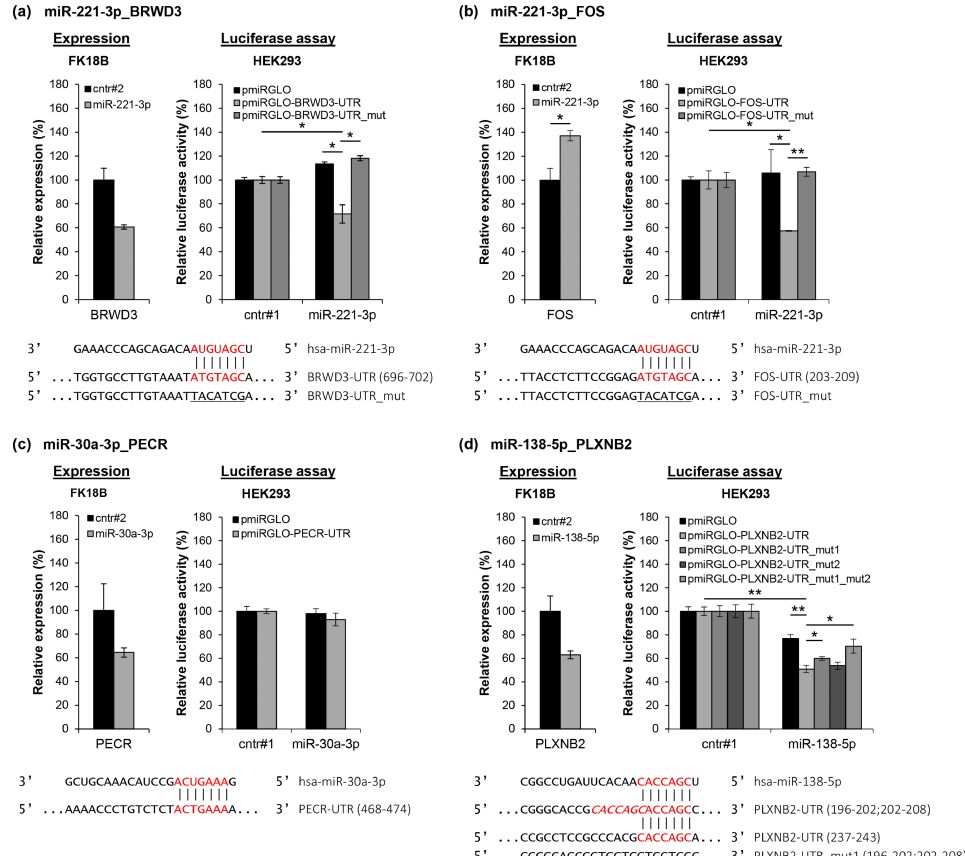
Figure 4. Confirmation of miRNA-mRNA interactions. Predicted miRNA-mRNA interactions ( a ) miR-221-3p_BRWD3, ( b ) miR-221-3p_FOS, ( c ) miR-30a-3p_PECR, and ( d ) miR-138-5p_PLXNB2 were investigated using mRNA expression analysis and dual-luciferase reporter assays. Left panel: E ff ects of ectopic expression of the miRNA on the expression level of its predicted mRNA target. Expression levels were determined by qRT-PCR in late passage FK18B cells (ca. passage 190) transfected either with a negative control (cntr#2) or with the respective miRNA mimic. Data was normalized to SNRPA. Mean and standard deviation of two technical replicates are shown. Right panel: Dual-luciferase reporter assay to confirm direct interaction between the miRNA and its predicted target mRNA. HEK293 cells were transiently transfected with a negative control (cntr#1) or the respective miRNA mimic in combination with either an empty pmiRGLO vector, a pmiRGLO construct containing the predicted binding site (pmiRGLO-predicted target-UTR), or a pmiRGLO construct containing a mutated binding site (pmiRGLO-predicted target-UTR_mut). MiRNA, UTR, and binding sites are indicated in the lower panel. Mean and standard deviation of three technical replicates are shown. * p < 0.05, ** p < 0.005., according to the two-sided Student’s t